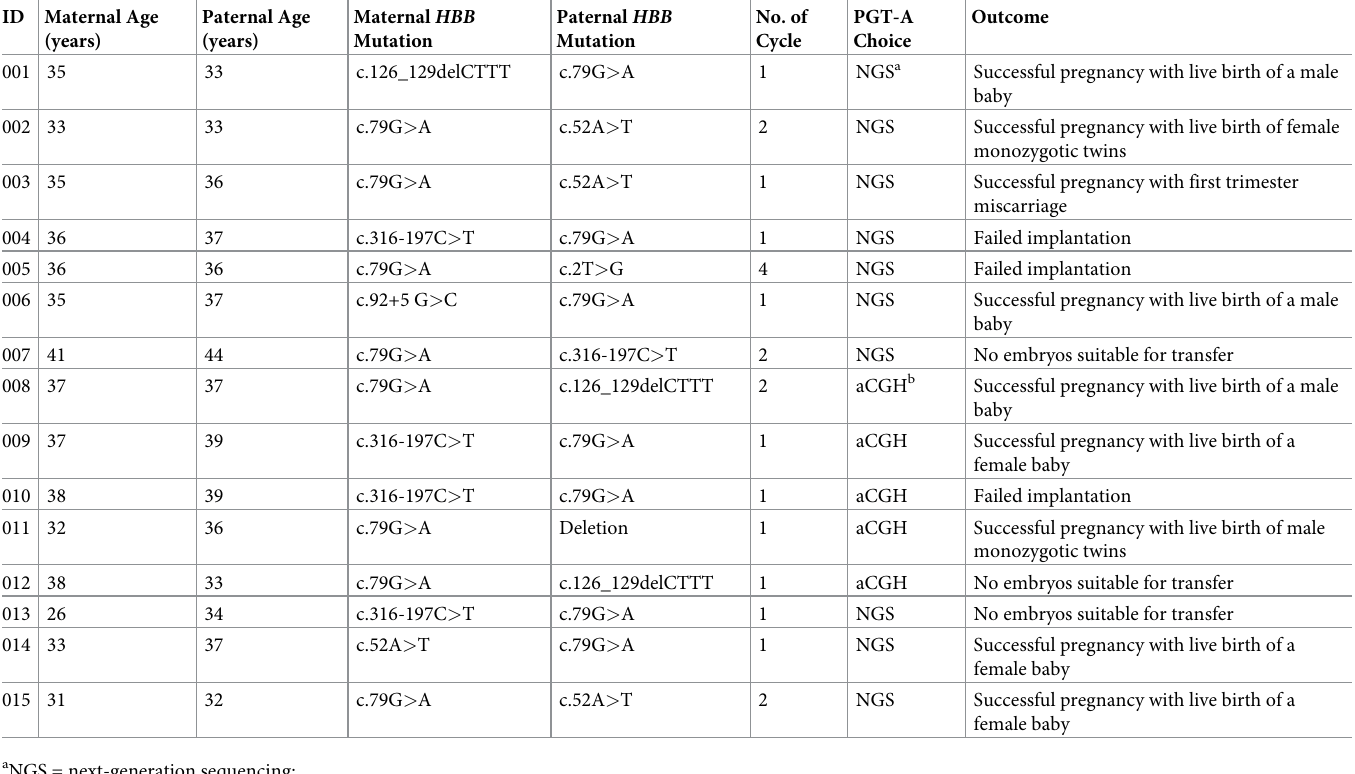
Table 3. Clinical and laboratory characterization of all couples obtaining assisted reproductive technology and preimplantation genetic testing for beta thalasse- mia/hemoglobin E disease in this study. ID Maternal Age